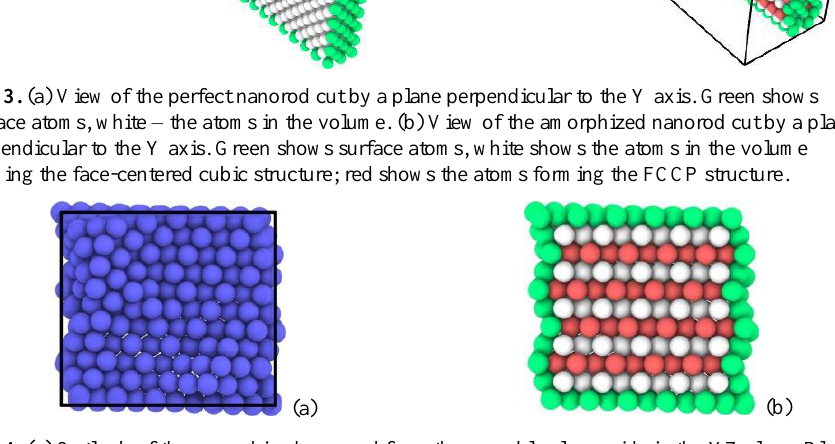
Fig. 4. (а) Outlook of the amorphized nanorod from the movable clamp side in the YZ plane. Blue indicates any atoms. (b) The cut of the amorphized nanorod by the plane perpendicular to the X axis. Green shows the surface atoms, white shows the atoms forming the face-centered cubic structure, red shows the atoms forming the FCCP structure.